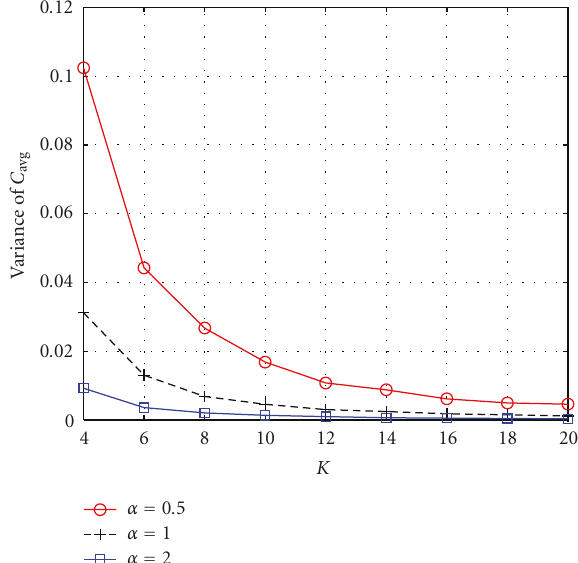
Figure 2: Variance of C avg versus di ff erent